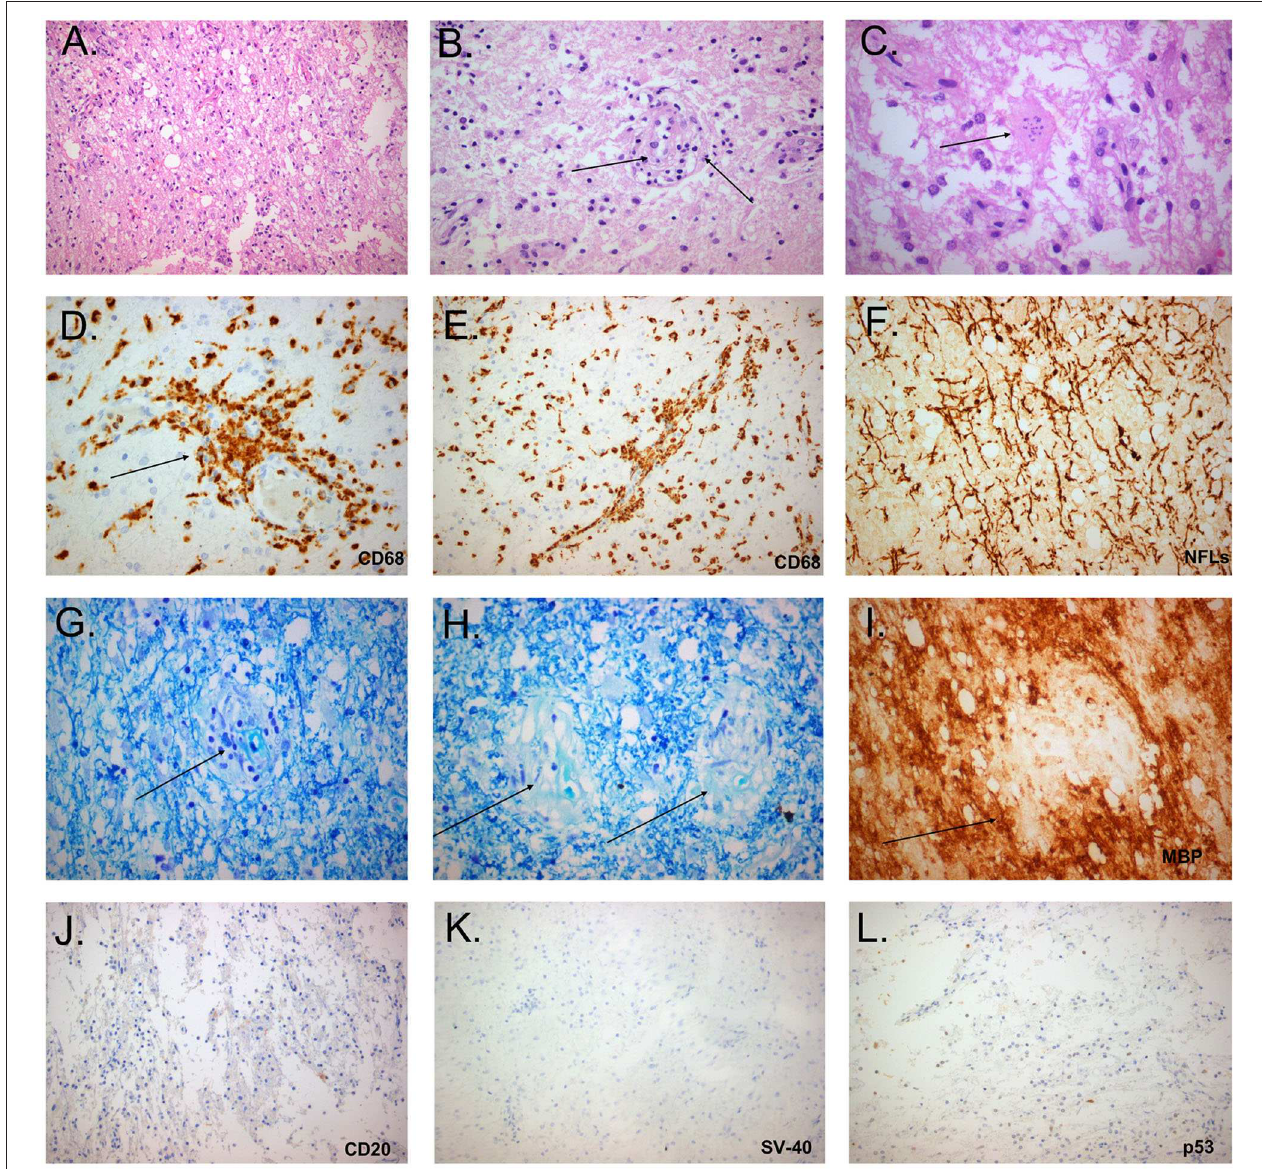
FIGURE 2 | Histopathological study of the tumefactive lesion showing active demyelination (second biopsy). Immunohistochemical (IHC) findings of parenchymal inflammatory infiltrates were invariably present and mainly consisted of macrophage rich lesions (A) , accompanied by foamy macrophages with perivascular cuffing ( B , black arrow) and astrocytes with granular mitosis, also known as Creutzfeldt-Peters cells ( C , black arrow: Creutzfeldt cell with fragmented micronuclei) (hematoxylin and eosin stain). Tissue section with extensive macrophage infiltration ( D , IHC for CD68/clone PGM1), with mainly perivascular location ( E , black arrow). Relative axonal preservation (IHC stain for neurofilaments) (F) . Demyelination was observed as a loss of Luxol fast blue staining (Kluver-Barrera stain), and was most obvious in perivascular areas ( G , black arrow, region of pallor, indicating myelin loss). Presence of granules of myelin inside the cytoplasm of macrophages, in contrast to elongated structures forming the classical myelin sheaths ( H , black arrows, granules of myelin). Perivascular demyelination was also evident by loss of Myelin Basic Protein (MBP), in perivascular spaces ( I , black arrow, IHC stain for MBP). Only few B cells were observed in tissue sections ( J : IHC for CD20). Progressive multifocal leukoencephalopathy was excluded by the absence of staining with antibodies against Simian Virus-40 and p53 ( K,L , respectively).